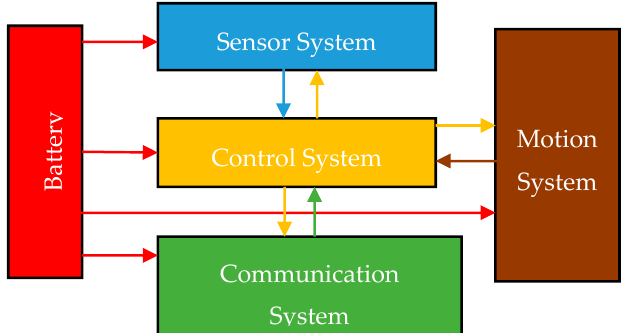
Figure 2. Energy consumption composition of a Mobile Robot (MR) and signal transmission.